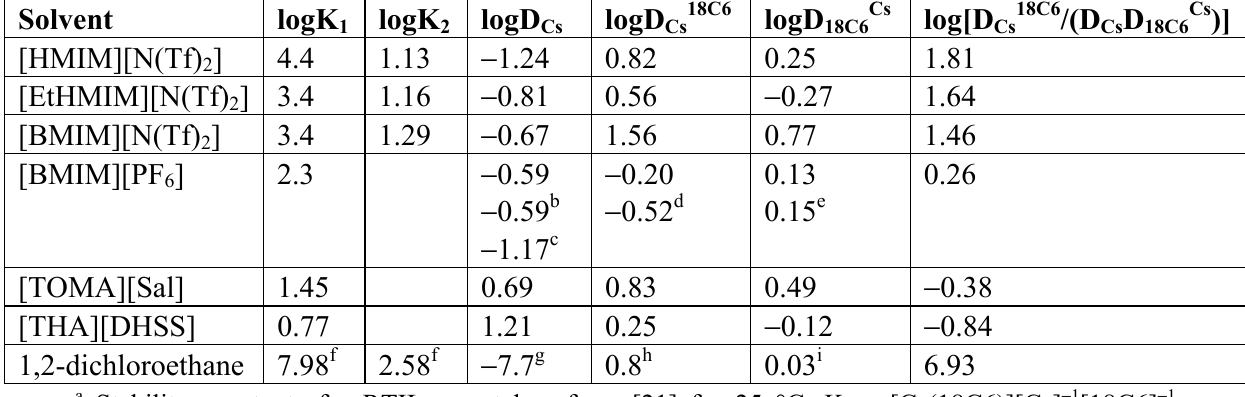
Table 4. Stability Constants of Cesium Complex Formation with 18C6 in RTIL and Extraction Efficiency from Water at 22 °C and pH 5 – 7 a